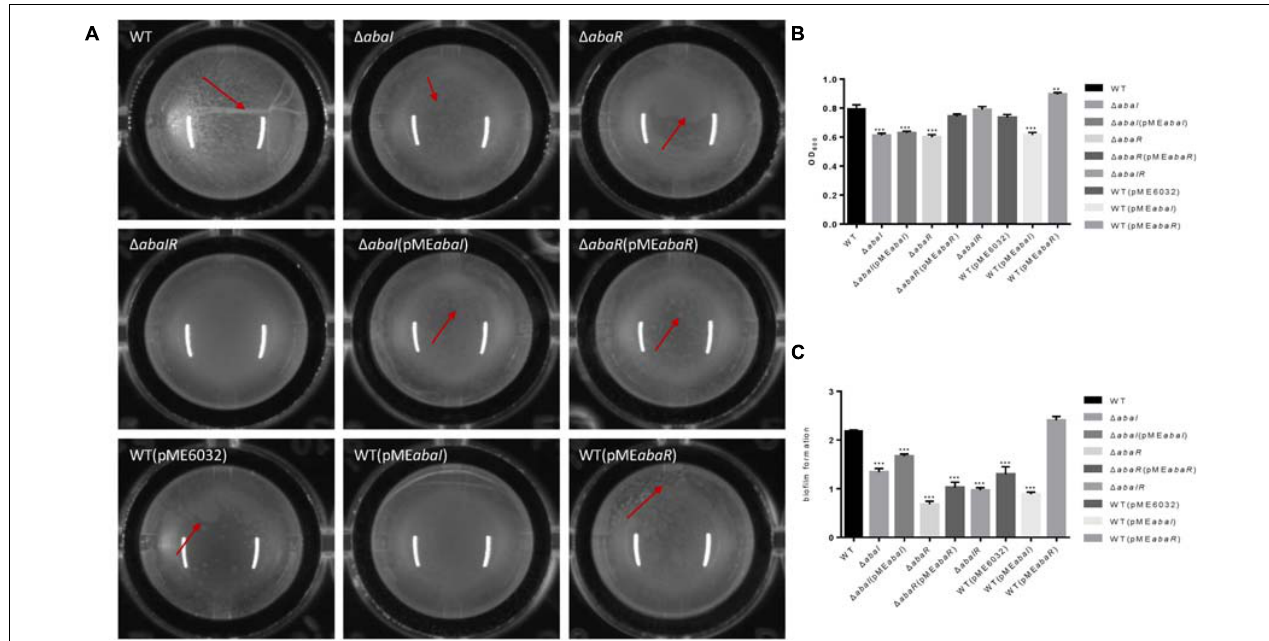
FIGURE 4 | (A) Visual changes in biofilm formation in 96-well plates for 24 h at 37 ◦ C; images were taken after 24 h of growth. The red arrow showed the biofilm produced in the liquid–air interface, known as pellicle biofilm. (B) The absorbance of bacterial solution was detected by OD 595 . (C) Biofilm formation on plastic at 37 ◦ C as determined by crystal violet staining. Markers show the OD 595 compared with WT in individual biological replicates. ** P < 0.005; *** P <